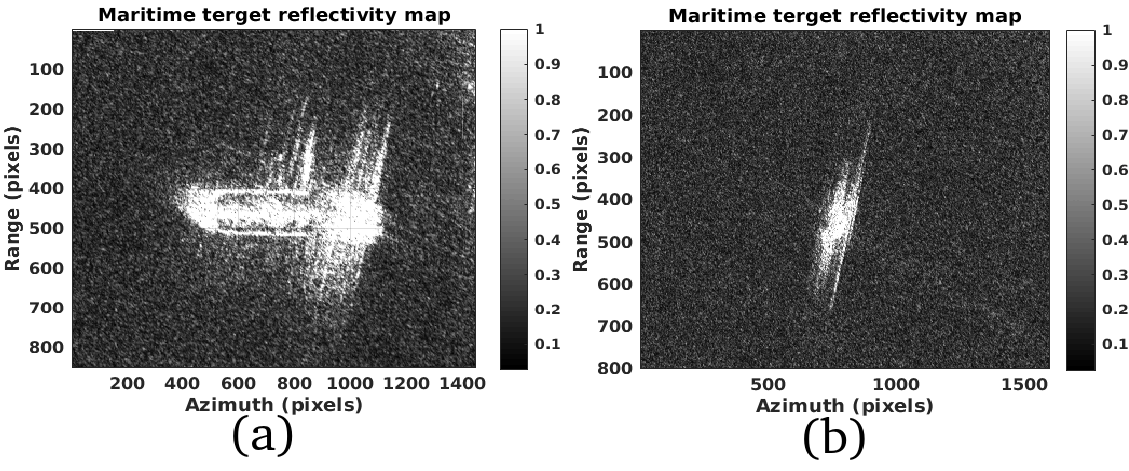
Figure 24. ( a ): Large ship SAR image. ( b ): Small ship SAR image.